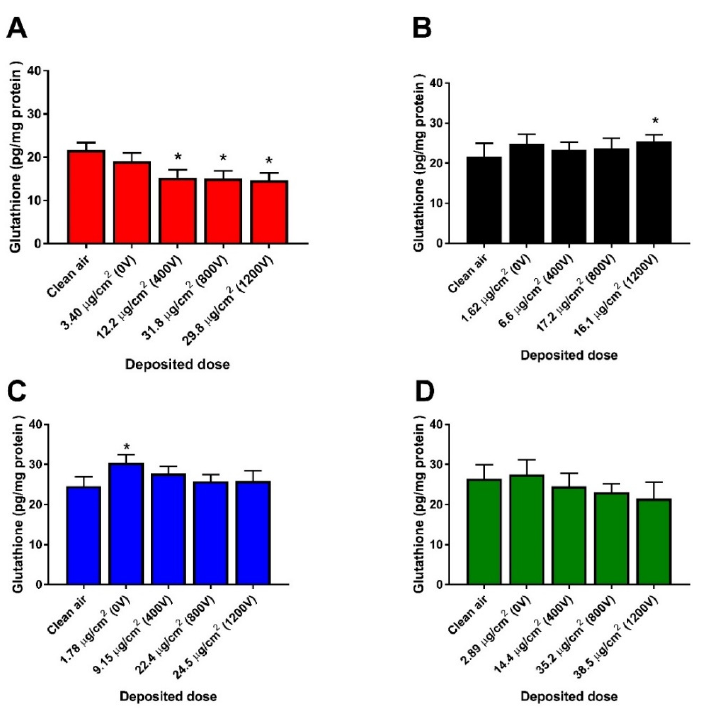
Figure 5. Glutathione levels measured in HBE cells after 4 h exposure to TiO 2 agglomerates at the ALI. 17 nm-SA ( A ), 17 nm-LA ( B ), 117 nm-SA ( C ), and 117 nm-LA ( D ). Data are expressed as means ± SD from two independent experiments with six replicates each. p < 0.05 (*) represent significant difference compared to control (One-way ANOVA followed by Dunnett’s multiple comparison test).